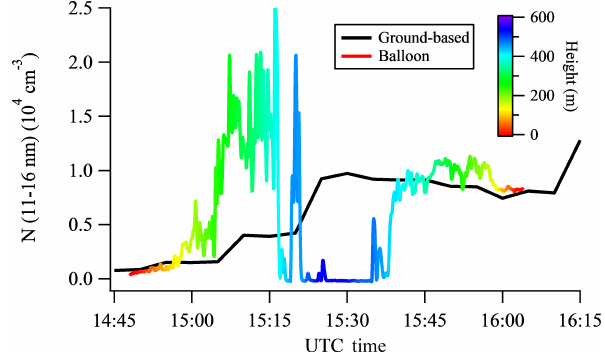
Figure 4. Time evolution of particle number concentrations in the size range of 11–16nm at SGP during the initial period of new particle formation on 12 May 2013 obtained by the ground-based ground-based scanning mobility particle sizers and tethered balloon